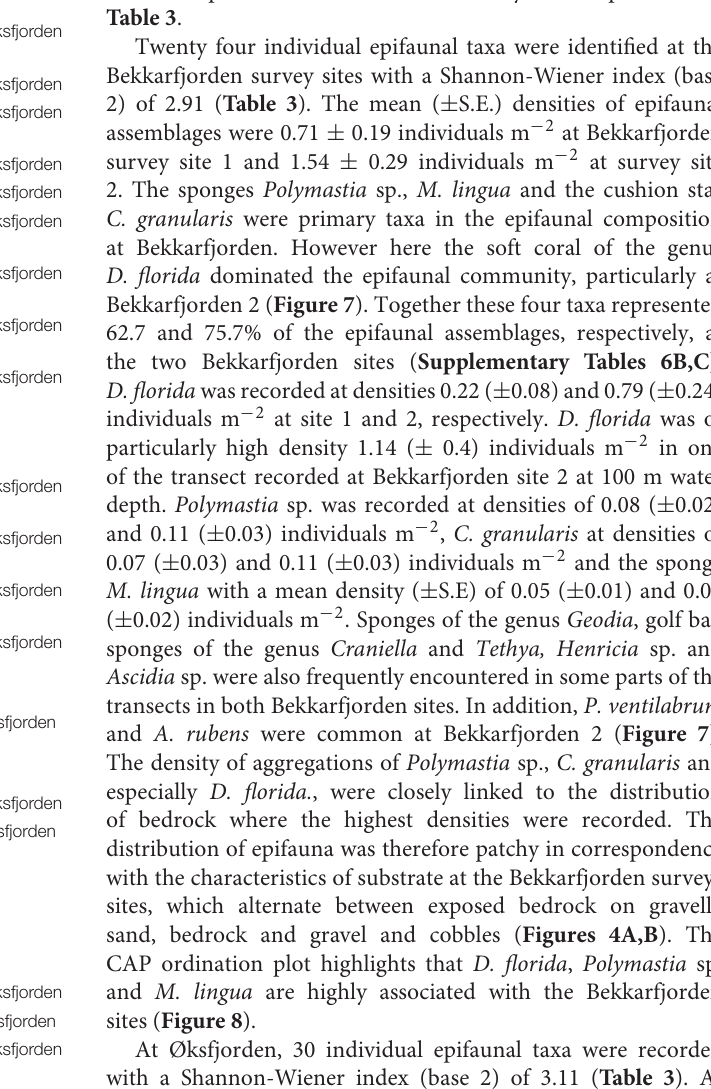
TABLE 3 | Epifaunal taxa observed in towed camera transects at each study area.